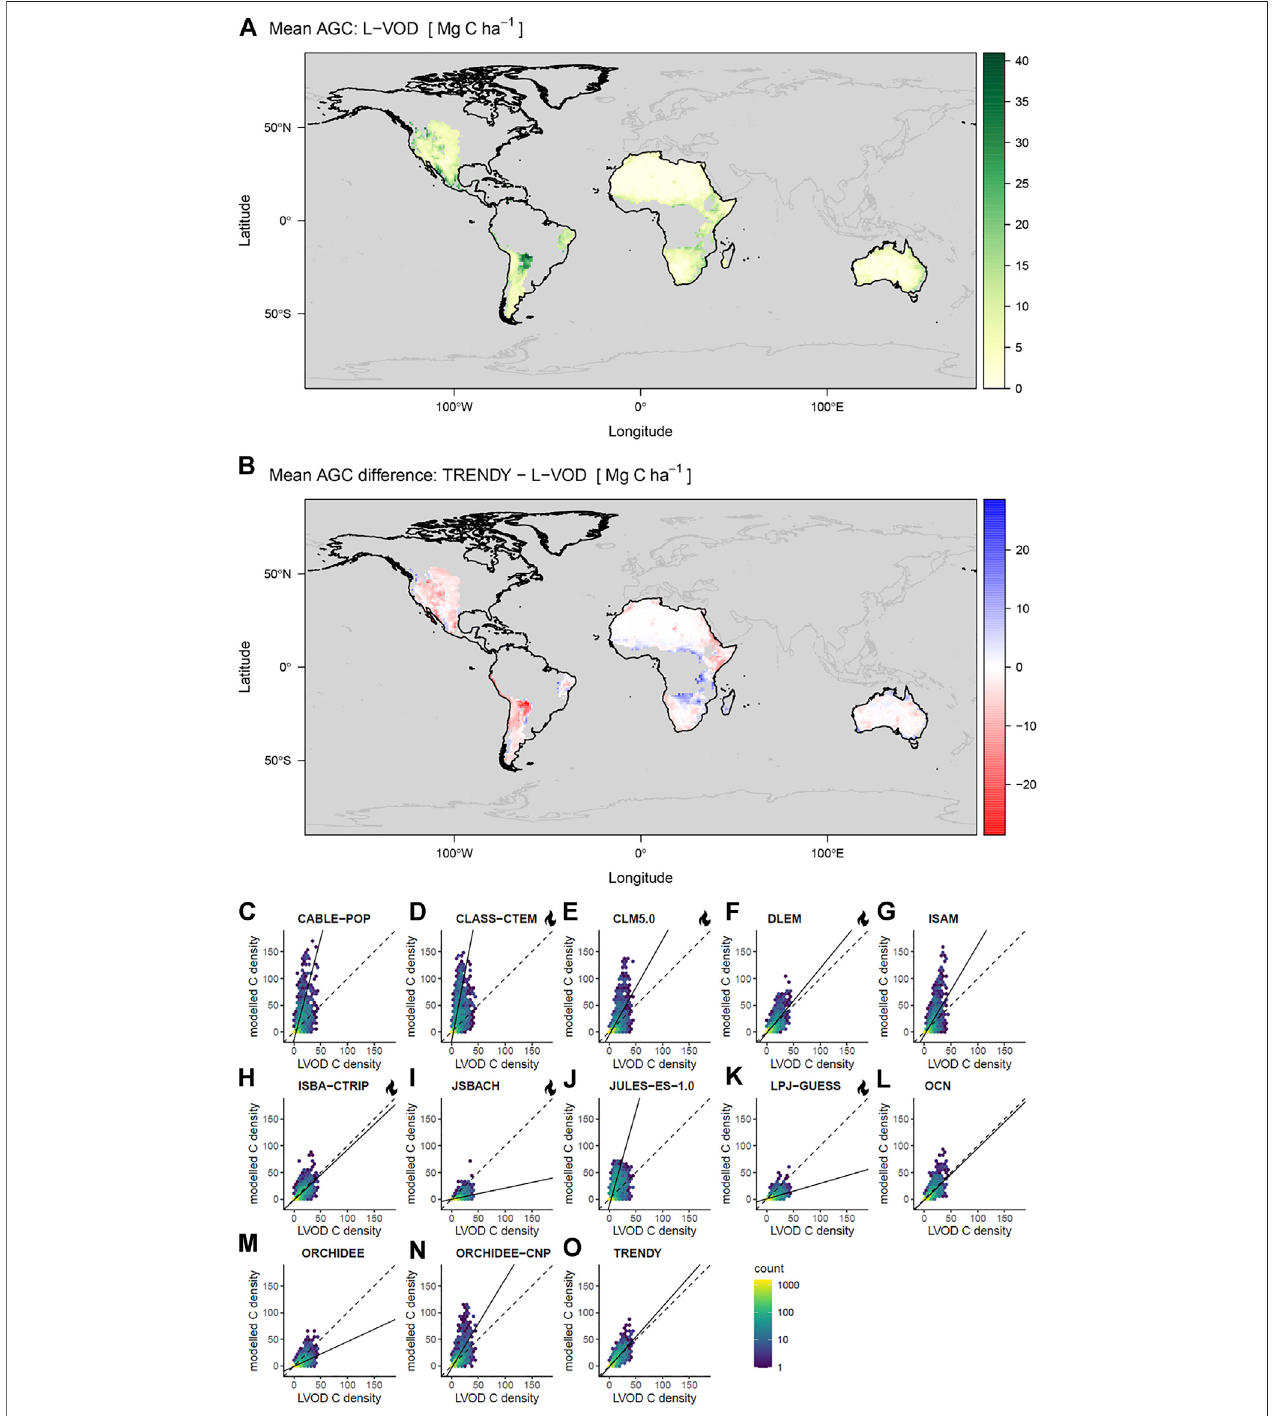
FIGURE4|(A) meanbiomassinferredfromL-VOD, (B) differencebetweenL-VODretrievalandtheTRENDYmeanAGC,theregionsanalysedareoutlinedinblack with other regions excluded due to higher RFI. (C – O) Pairwise pixel covariance in mean AGC density estimated from L-VOD versus modelled values over the focal dryland regions, displayed as counts per hexagonal bin. Dashed lines represent 1:1 on the carbon density plots and solid lines are linear models fi tted with total least squares. Units are biomass carbon density (Mg C ha − 1 ) and means are calculated over the 2011-2018 period. Note that in (C – O) models are fi tted to weighted valuesbutweightsarenotillustratedwhile (A,B) includeonlygridcellswithcentroidswithinthedrylandmask.LSMswithexplicitrepresentationof fi reareindicatedwitha fl ame icon.